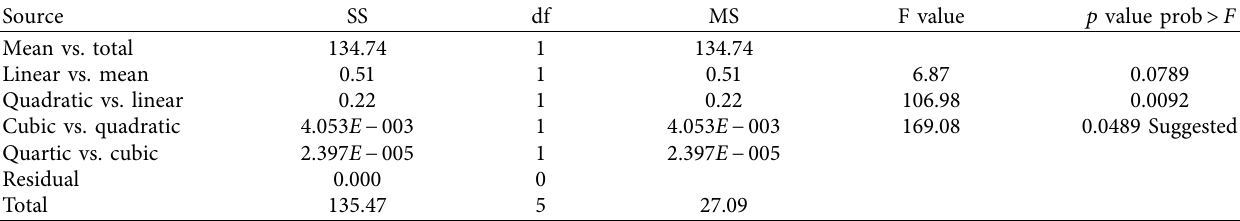
Table 11: Sequential model sum of squares (type I) for compressive strength response.